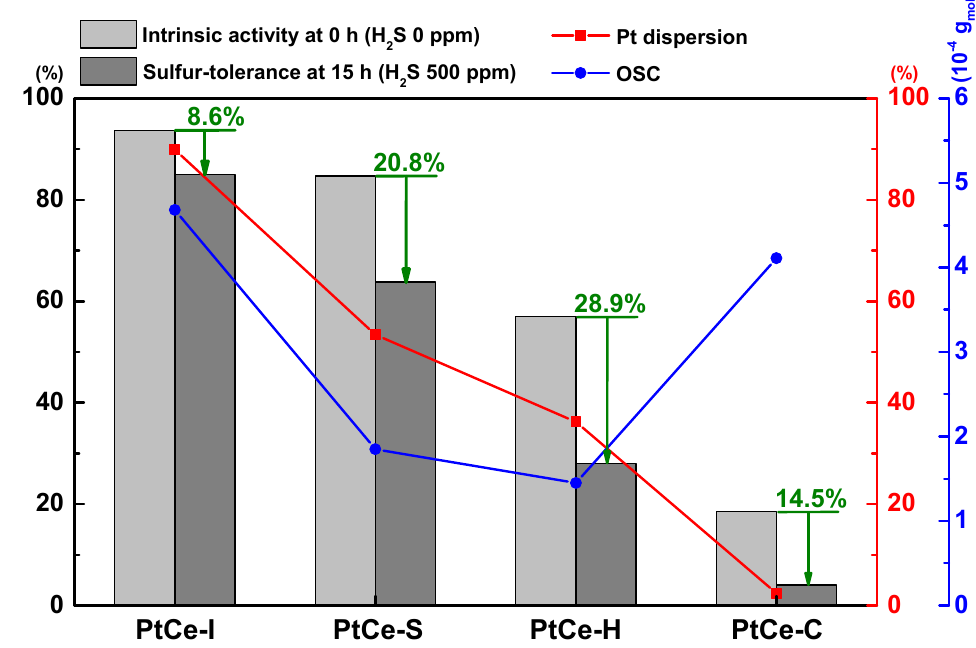
Figure 8. Relationship between the physicochemical properties and the performance of CeO 2 ‐ sup ‐ ported Pt catalysts prepared by various synthesis